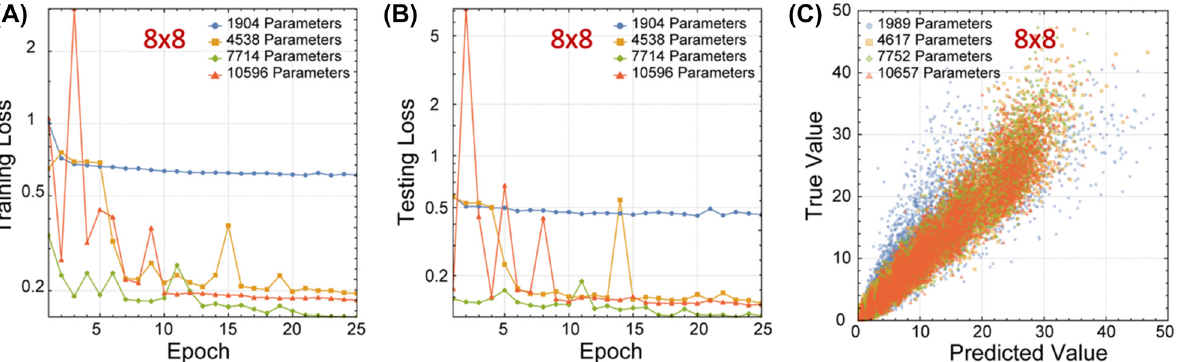
Figure 6: Training and testing results of upscaled eigenvalue solver for 8 × 8 matrices. (A)Thetraininglossfor8 × 8matriceseigenvaluesolverforeachparametercondition.(B)Thetestinglossfor8 × 8matriceseigenvaluesolver for each parameter condition. (C) The correlation between true value and predicted value for 8 × 8 matrices eigenvalue solver for each parameter